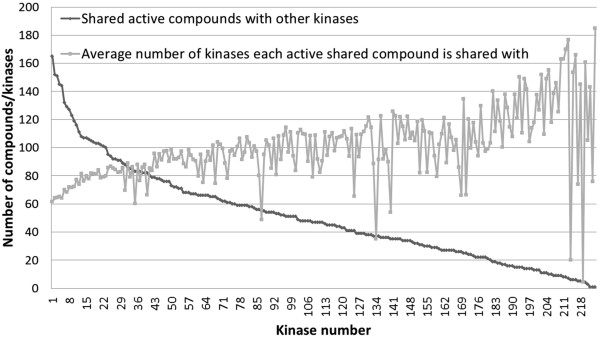
Compound promiscuity. The number of shared active compounds with other (1 or more) kinases is shown in dark gray, whereas the average number of kinases these active compounds are shared with for each kinase is shown in light gray. Only 1 kinase (NEK7) does not share any active compounds with other kinases. Of all kinases, 80% share over 20 active compounds which is of importance for establishing meaningful kinase SAR relationships. These compounds are shared with 51 kinases on average, suggesting the compouunds in the dataset to be relatively promiscuous on average.